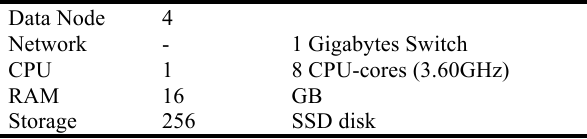
Table 2. Cluster hardware configuration